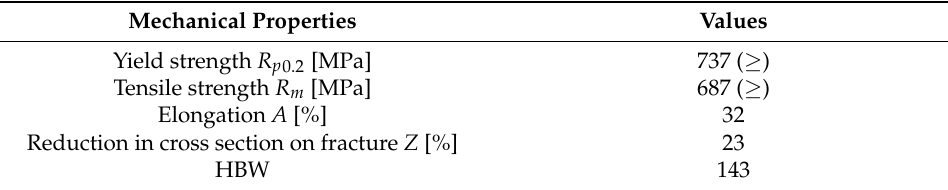
Table 3. Mechanical properties of K4002 nickel-based special